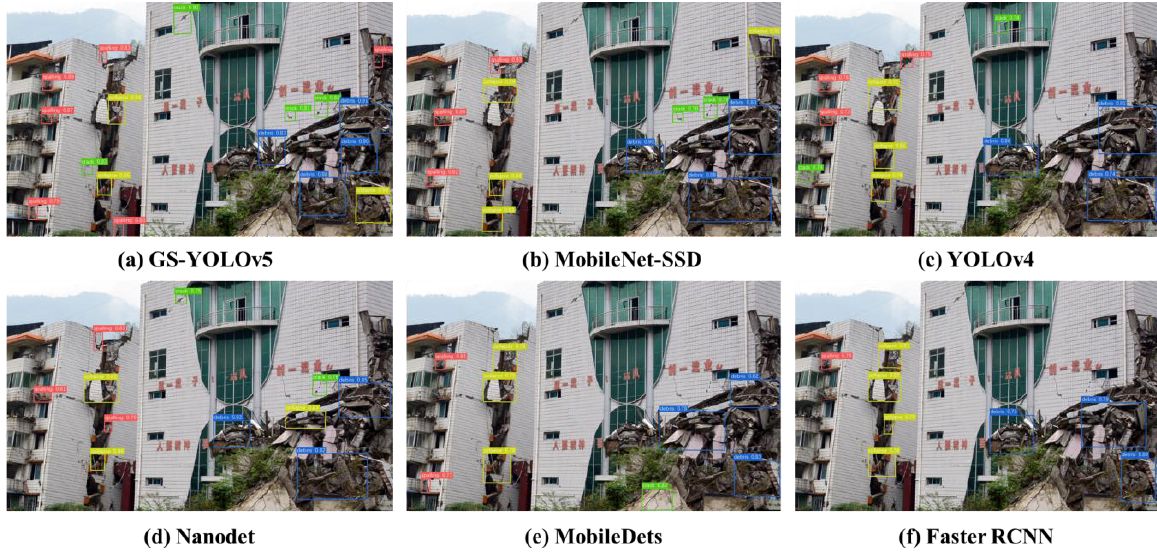
Figure 12. Comparison results of building damage detection using different methods. (Note: The Chinese term in each image refers to the sign or slogan on the building's exterior).